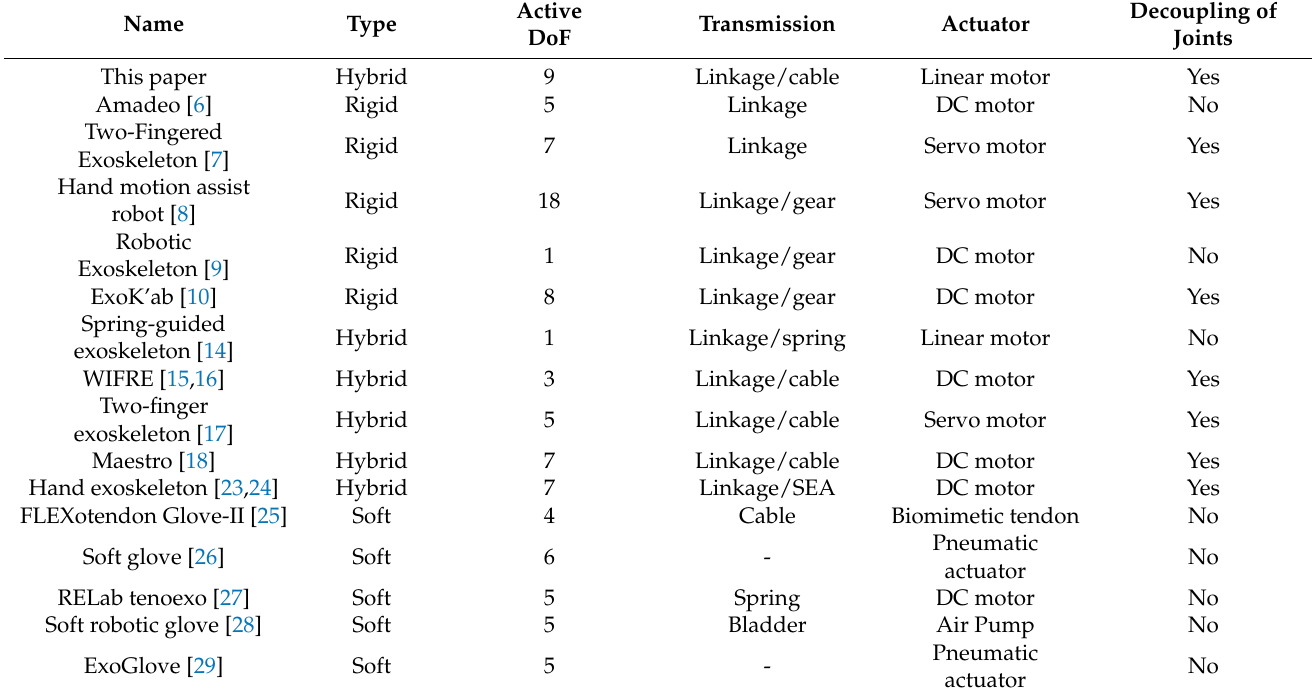
Table 1. Comparison of Hand Rehabilitation